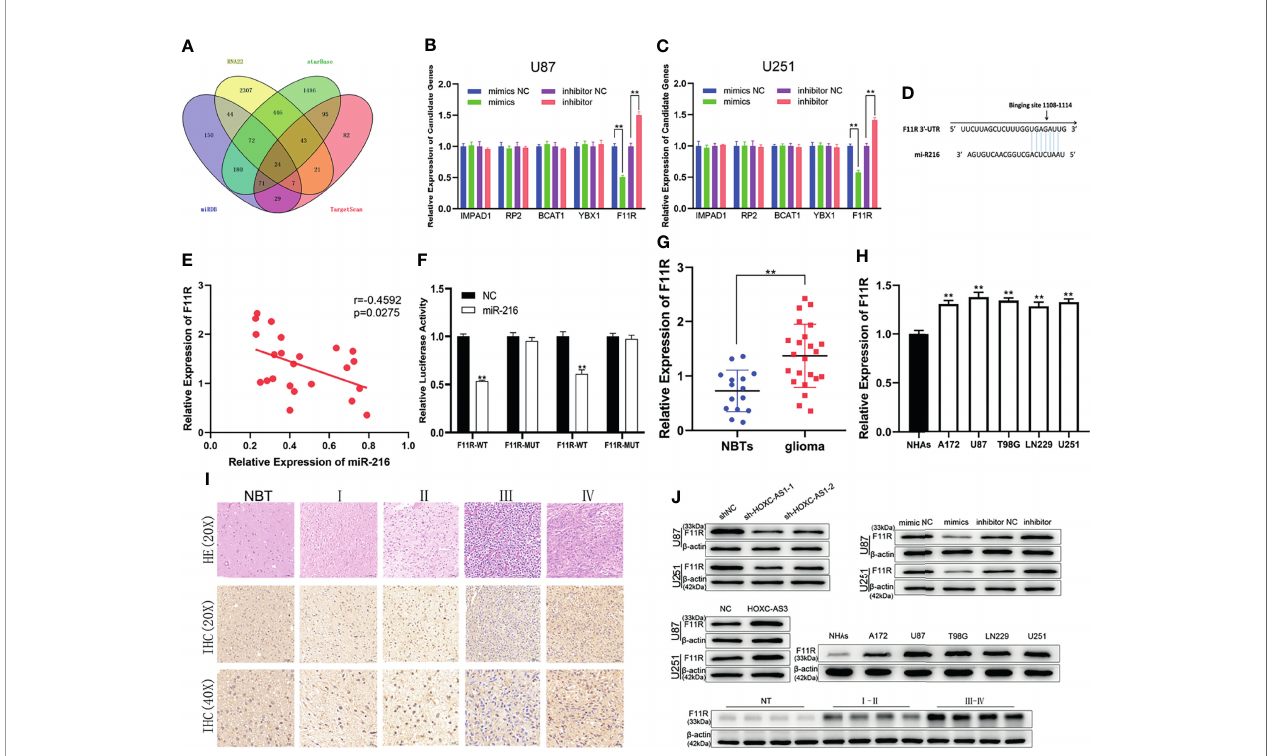
FIGURE 3 | | MiR-216 directly binds F11R to regulate the level of F11R. (A) 24 potential downstream genes of miR-216 were predicted using online databases. (B, C) The effect of miR-216 on the expression of candidate mRNAs in U87 and U251 cells was detected by qRT-PCR. (D) Binding sites of miR-216 on F11R. (E) Pearson correlation analysis showed that F11R was inversely correlated with miR-216 in glioma tissues. (F) The association between miR-216 and F11R was veri fi ed by luciferase reporter assay. (G) Expression of F11R in normal brain tissues and glioma tissues. (H) Expression of F11R in normal human astrocytes and glioma cell lines. (I) Expression of F11R in different grades of glioma identi fi ed using immunohistochemistry. (J) The expression levels of F11R in different tissues and cell lines were tested by western blot analysis. At the same time, it was veri fi ed that F11R was regulated by HOXC-AS3 and miR-216. Pearson ’ s correlation analysis for (E) ; t-test for (B, C, F, G) ; one-way ANOVA and post hoc test for (H) . **P <